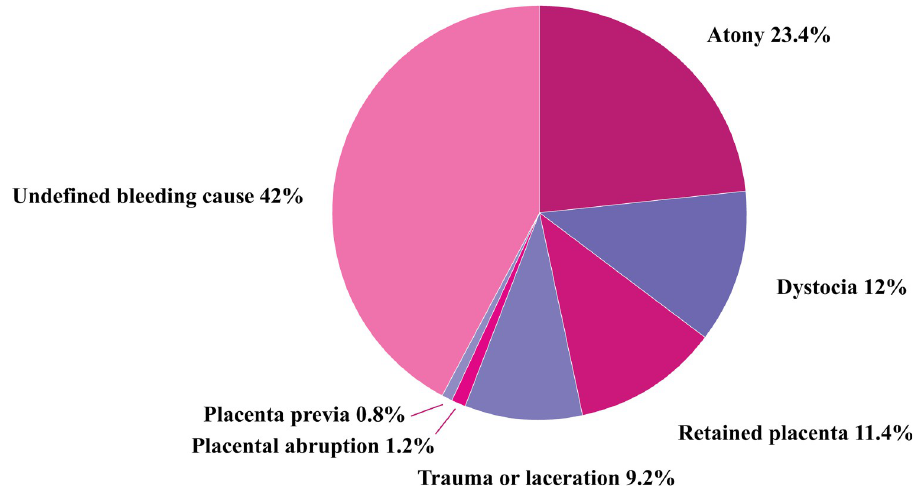
Fig 1. Occurrence of type specific postpartum hemorrhage ( > 500ml) (1967–2017); singleton births, � 22 weeks of